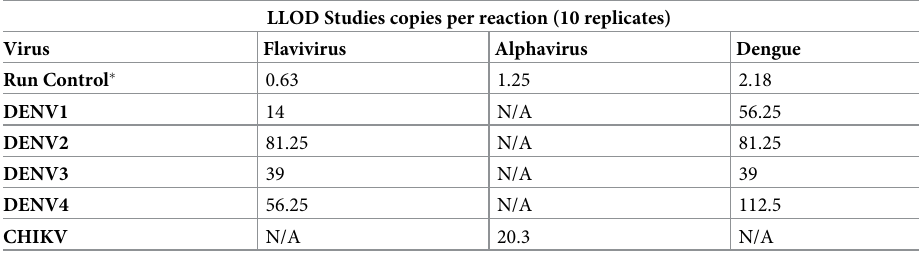
Table 3. LLOD for each viral target of the